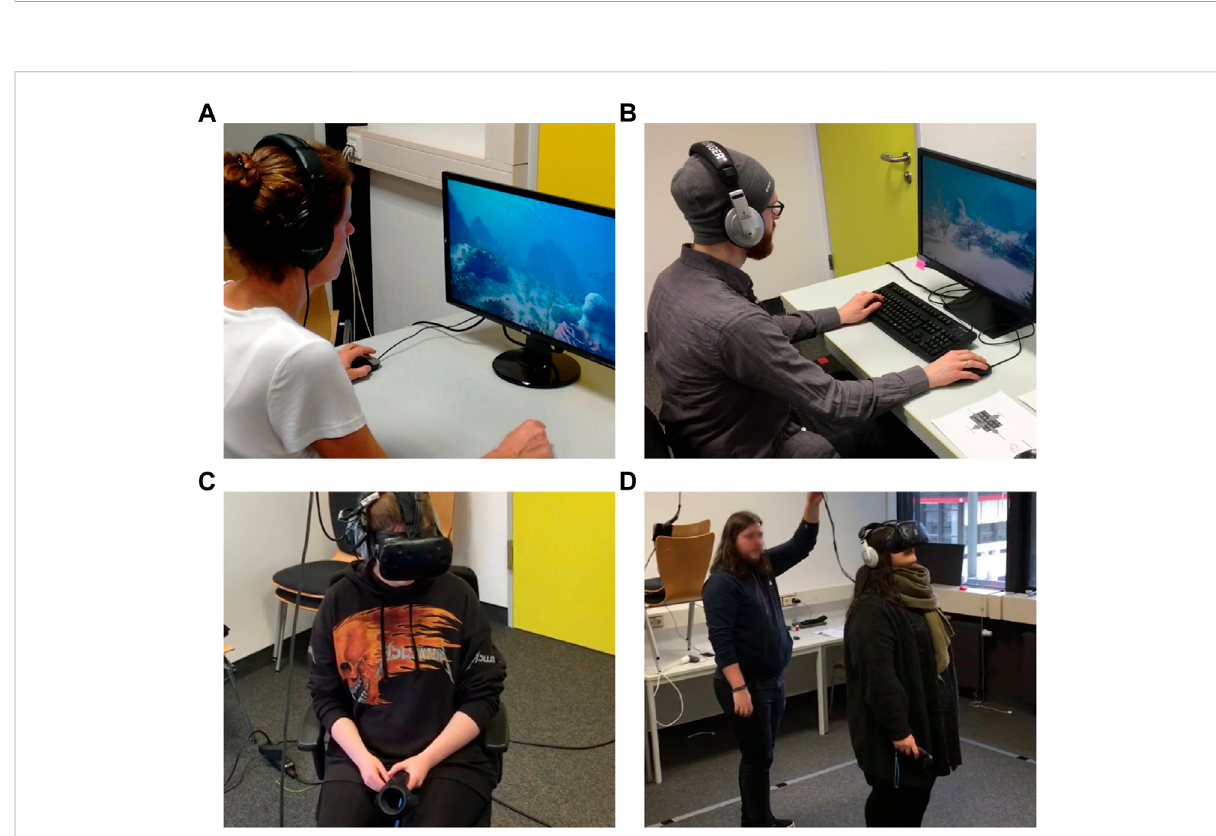
FIGURE 5 The four setups corresponding to the four conditions as depicted in Figure 4. Notice the missing keyboard in (A) and the swiveling chair in (C) , bothofwhichareinthe RestrictedNavigation condition.Images (C) and (D) bothshowthesetupsforthe HighImmersion condition; (B) and (D) show the Full Navigation